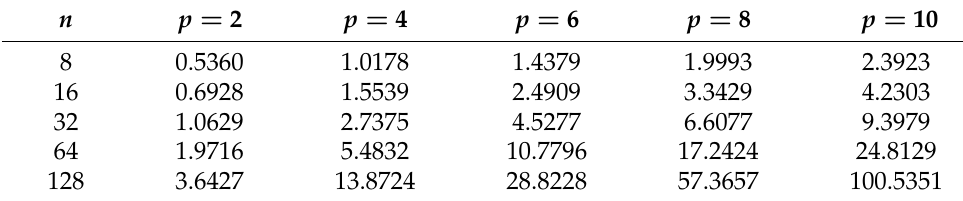
Table A2. Execution time (ms) of PDIST . EncodeX operation on desktop PC.